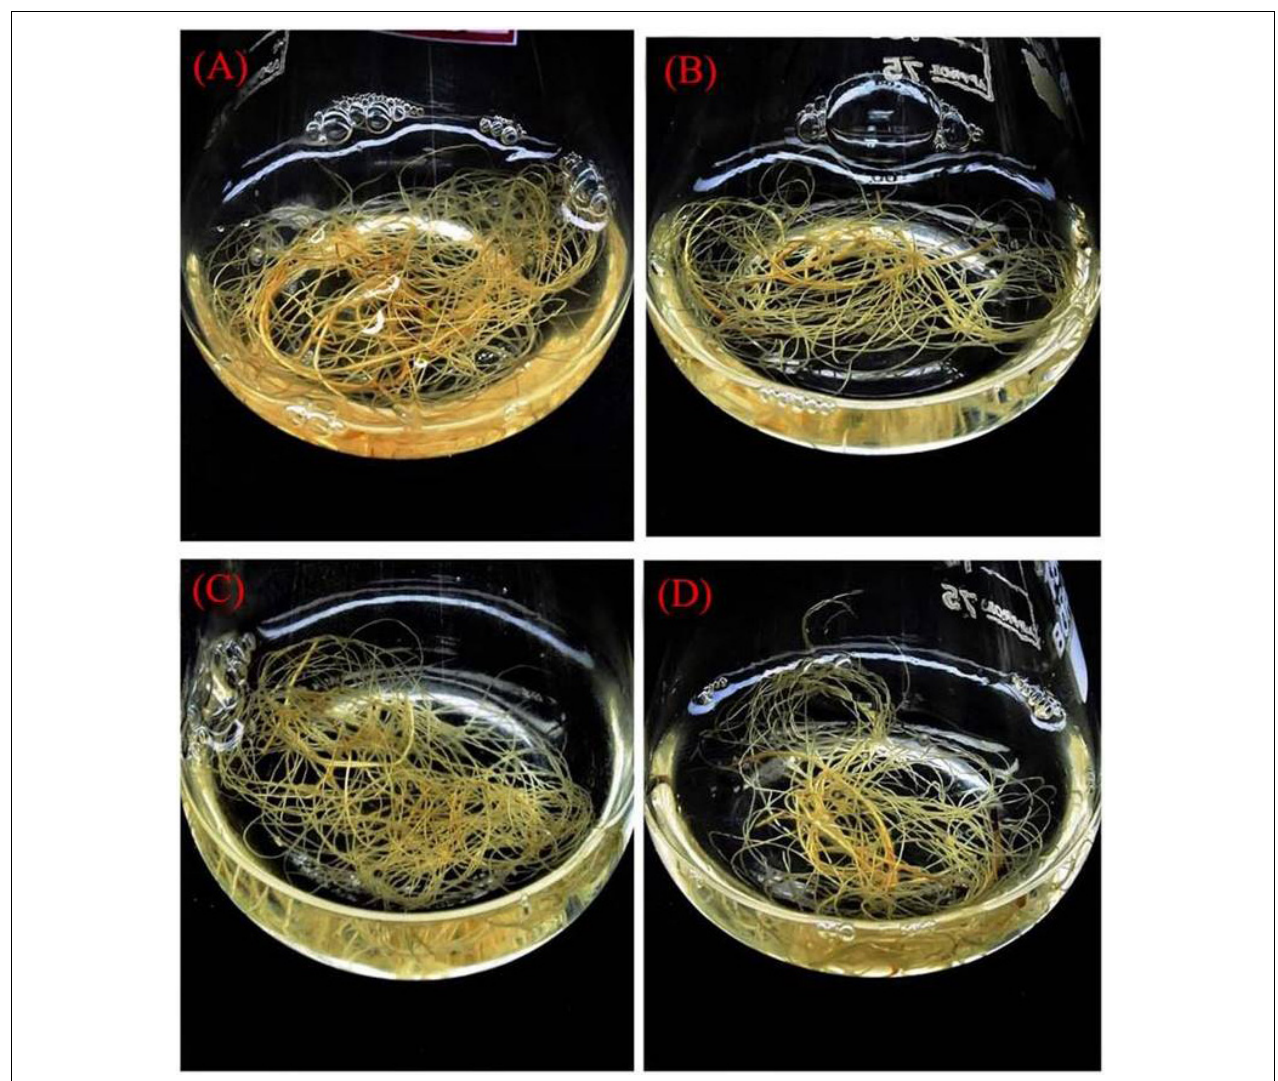
FIGURE 6 | Enhancement of precursor treated with biomass accumulation from hairy root culture after 12 weeks. (A) A 4 strain hairy root with 1/2 MS + FDP 3 µ M. (B) A 4 strain hairy root with 1/2 MS + FDP 1 µ M. (C) R 1000 strain hairy root with 1/2 MS + FDP 3 µ M. (D) R 1000 strain hairy root with 1/2 MS + FDP 1 µ